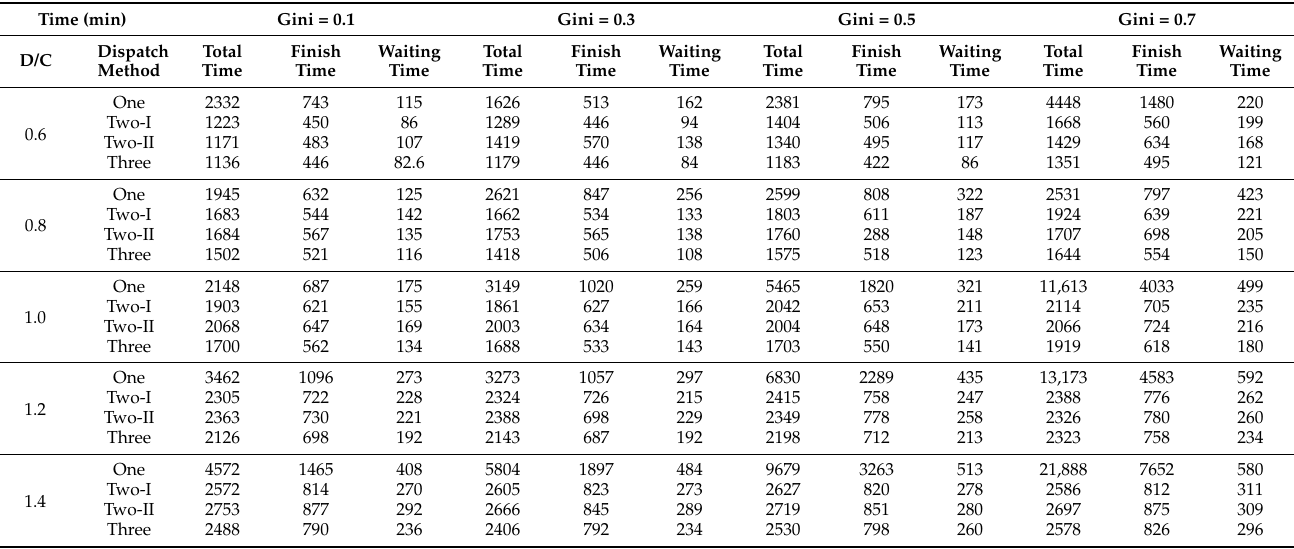
Table 4. Result of simulation. “One” indicates “reconnaissance and evacuation” in Level one; “Two-I” indicates “one- destination” in Level two; “Two-II” indicates “multiple-destination” in Level two; and “Three” indicates “dynamic routing” in Level